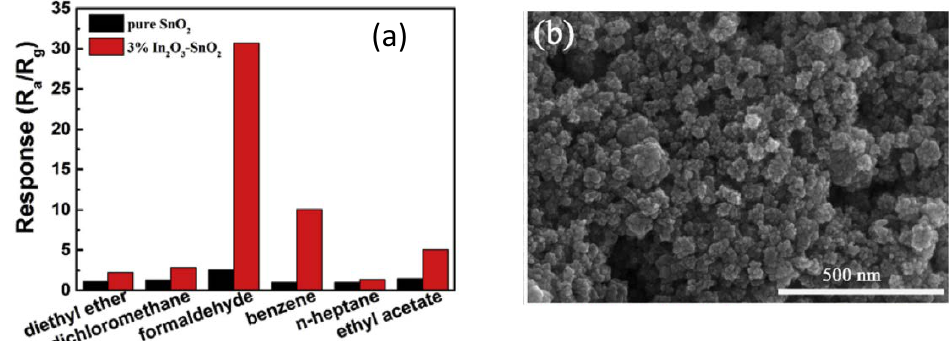
Figure 12. ( a ) Selectivity of pure SnO 2 and 3% In 2 O 3 -SnO 2 nanospheres towards 100 ppm of various VOC gases at 100 °C and ( b ) SEM image of 3% In 2 O 3 -SnO 2 nanostructure, “Reprinted/adapted with permission from Ref. [114]. 2018, Ge, W. et al.”.